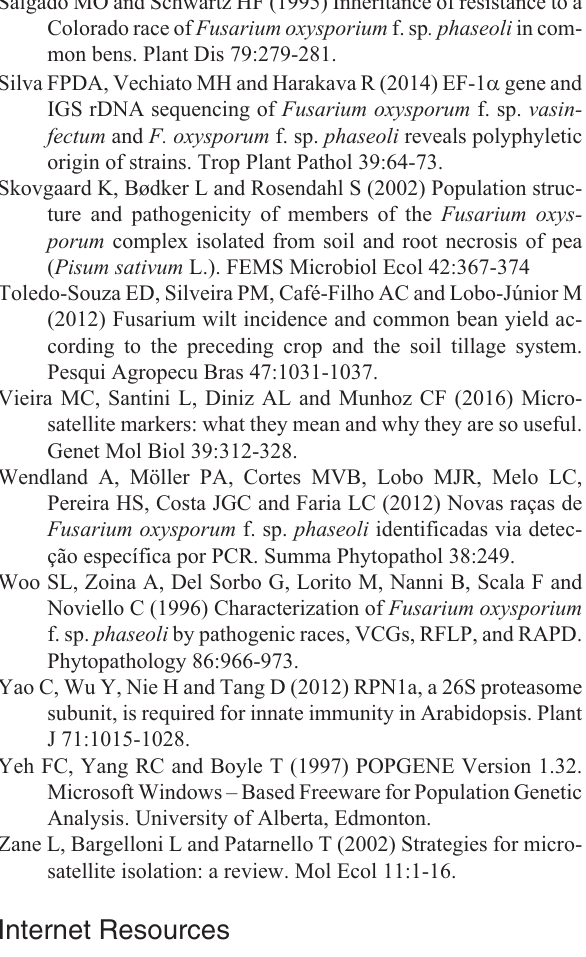
Figure S1 - Electropherogram with the peak of the allele of the microsatellite. Figure S2 - Number ideal cluster’s according to the method - ology of EVANO et al. (2005). Table S1 - Mean, standard deviation of the genetic parame - ters obtained for the 14